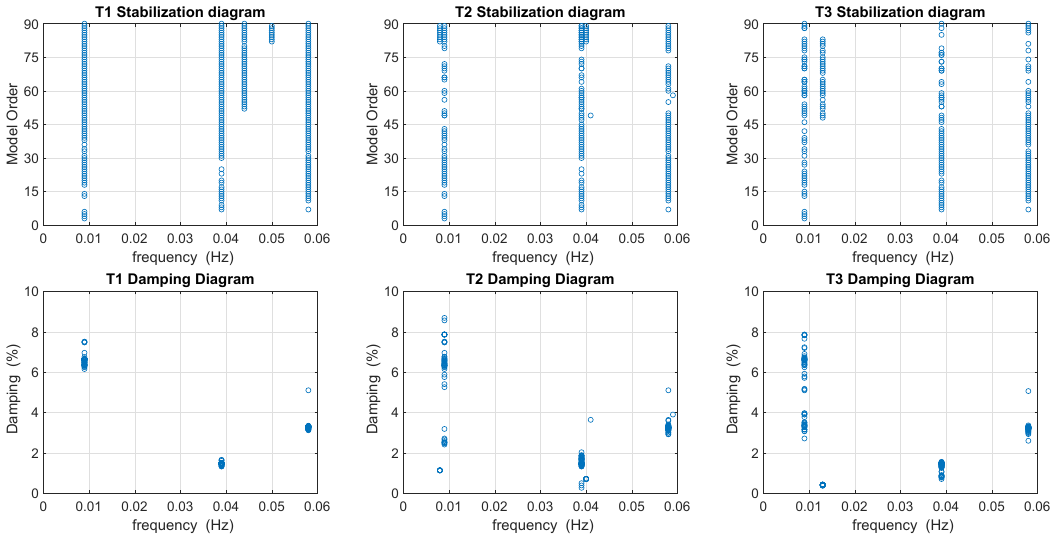
Figure 3. Stabilization and damping diagrams for Simulation T1, T2, and